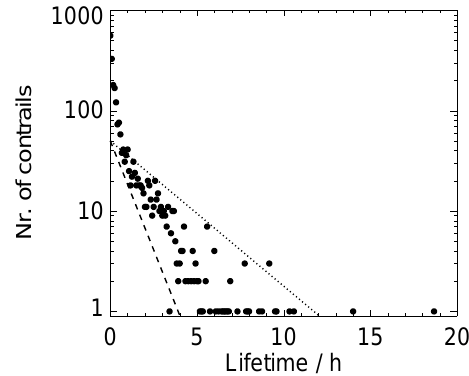
Figure 6. Lifetimes of the contrails studied. Dashed line: e -folding time 3h. Dotted line: e -folding time